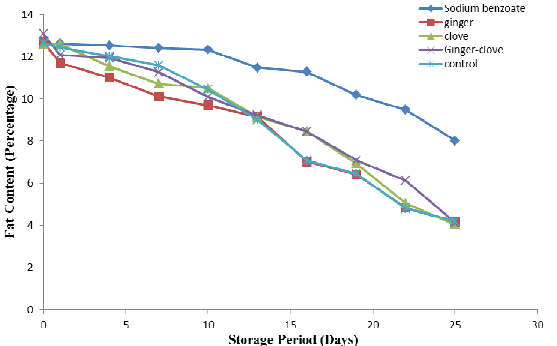
Fig. 14. Effects of various treatments on the fat content of soymilk samples at 3% concentration stored at refrigerated temperature for 25